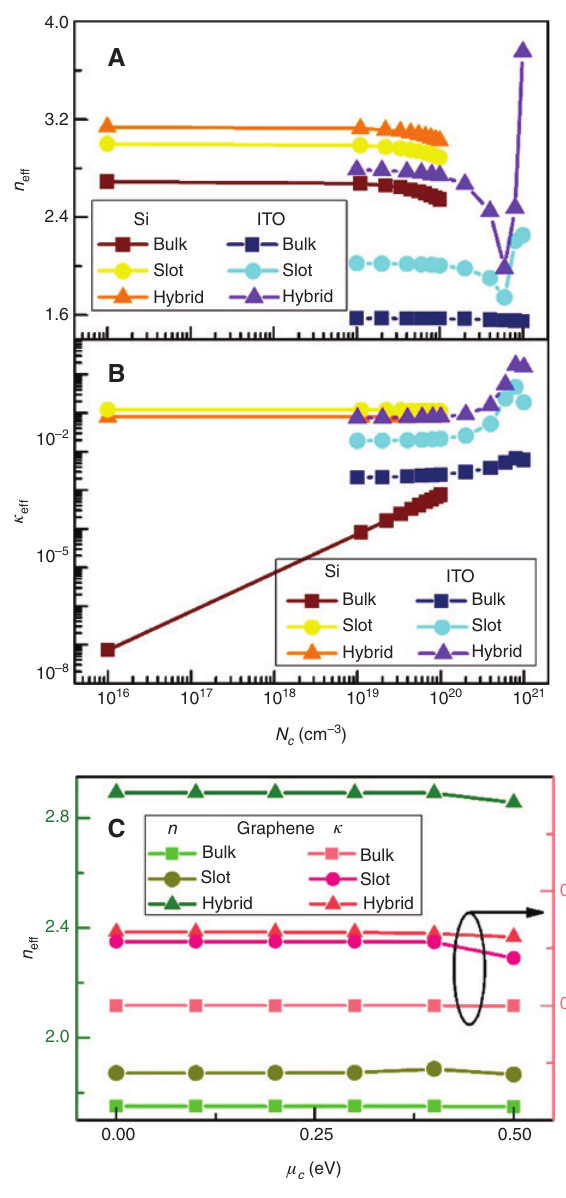
Figure 4: Simulated results for effective indices for all the modes in Figure 2 for different applied bias. (A) Real part of the effective refractive index for Si and ITO vs. carrier concentration, (B) imaginary part of the effective index, i.e. effective extinction coefficient for Si and ITO vs. carrier concentration, and (C) Real and imaginary parts of the effective index for graphene vs. chemical